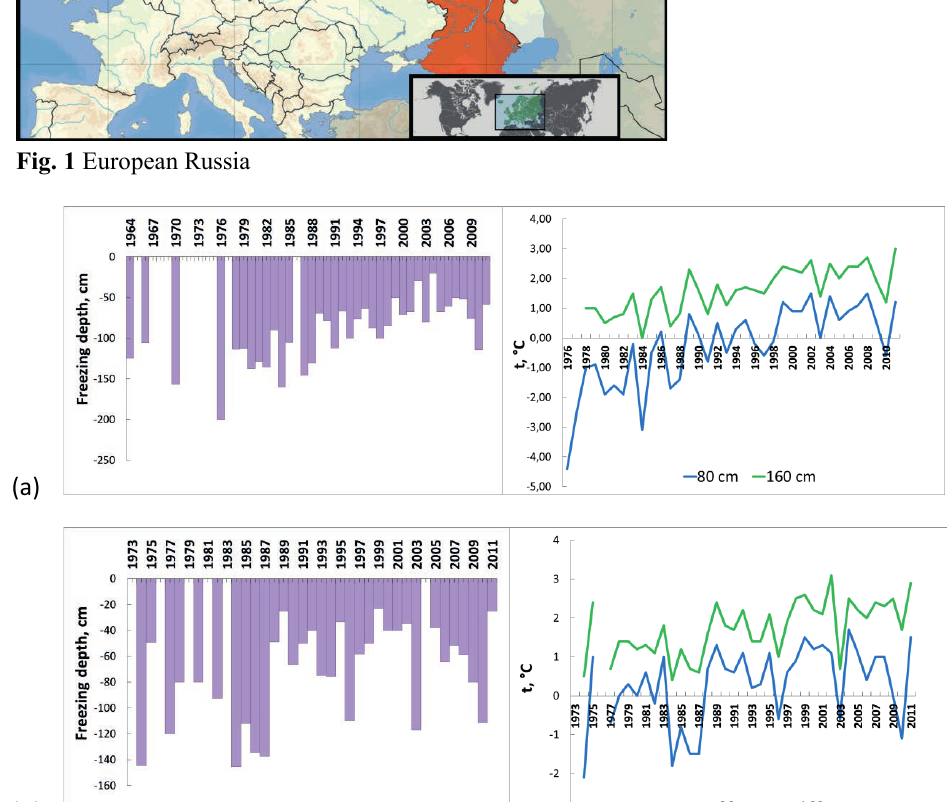
Fig. 2 (a) Left: Freezing depth at the hydrological stations in the middle reaches of the Volga R. (Sergach, Piana R.); right: minimum soil temperature during winter at depths of 80 and 160 cm. (b) Left: freezing depth at the hydrological stations in the basin of the Don R. (Elec, Sosna R.); right: changes in the minimum soil temperature during winter at depths of 80 and 160